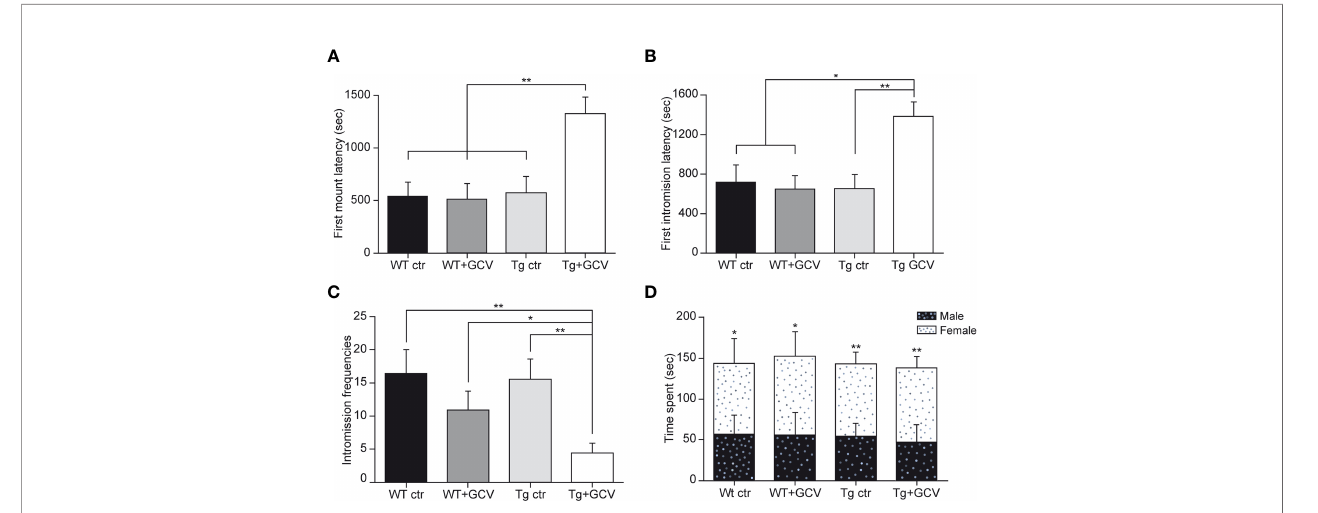
FIGURE 6 | Central GCV administration in Tg mice affected male sexual behavior. The latencies to fi rst mount (A) and to fi rst intromission (B) are increased in Tg +GCV male mice, while the intromission frequencies (C) are decreased after central GCV administration in Tg mice. Males of the four groups spend more time in close contact to a receptive female than an unfamiliar male (D) . Data are expressed as the mean ± SEM, n ≥ 6 for each group. *p<0.05,